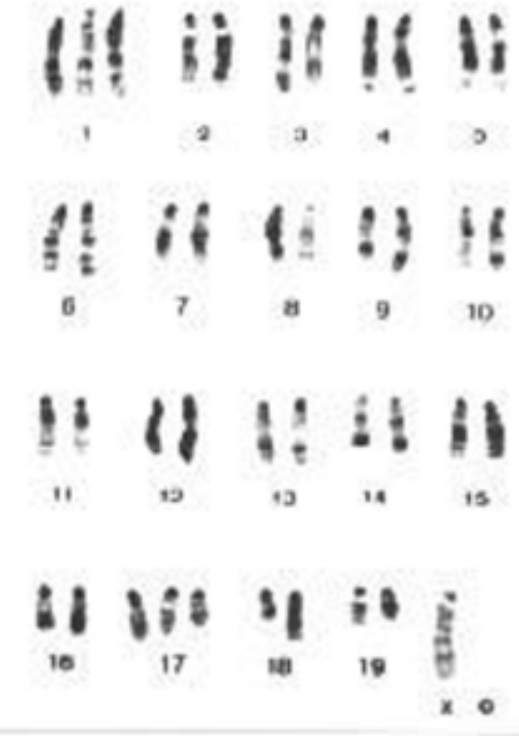
Figure 2 - GTG-banded karyotype of a HESS-3 cell with trisomy of chro- mosome 1 and 17 (Passage 39).